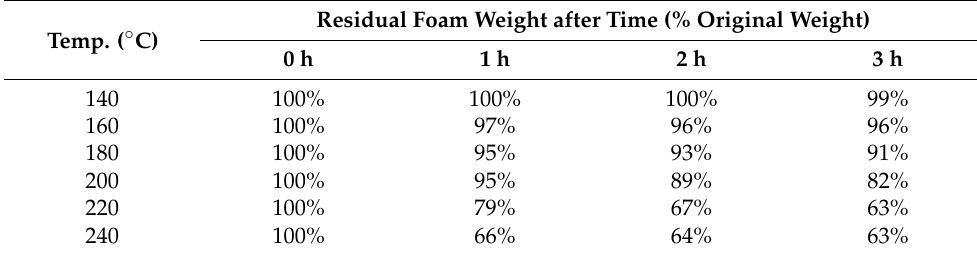
Table 3. Foam decomposition, temperature, and exposure time relationship. Temp. ( ◦ C)